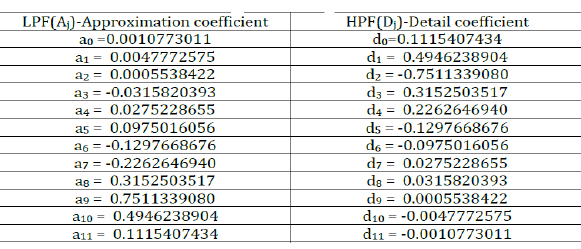
Table 2. Approximation and Detail Coefficient of